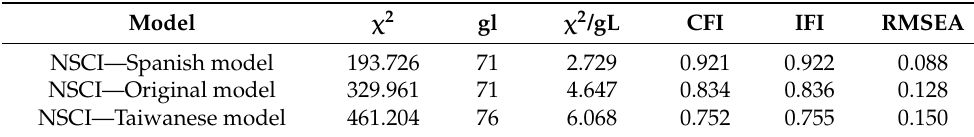
Table 3. Model fits for the different NSCI